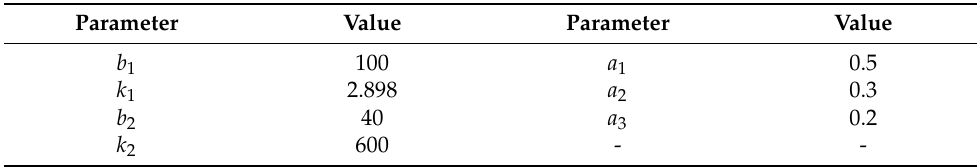
Table 7. Parameters for calculating